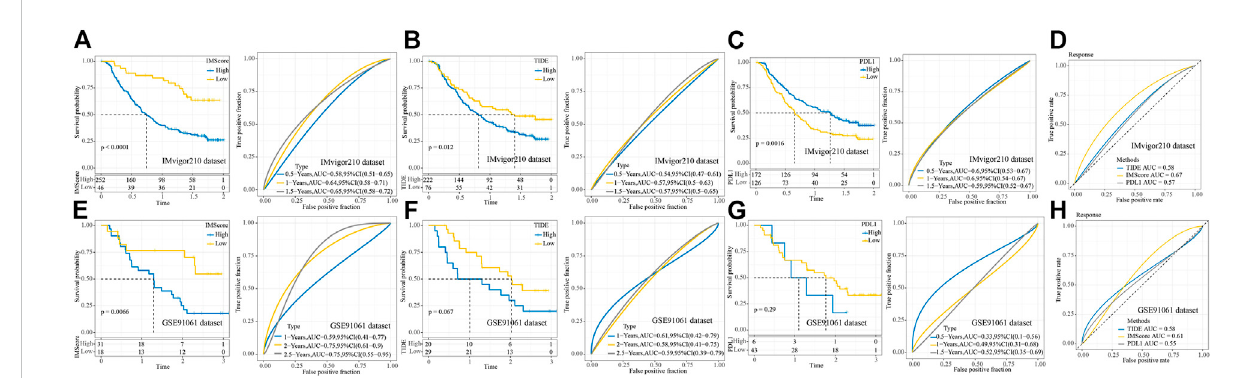
FIGURE 9 Performance of IMScore in immunotherapy datasets. (A) KM survival curve and ROC analysis of IMScore in the IMvigor210 dataset. (B) KM survival curve and ROC analysis of TIDE in the IMvigor210 dataset. (C) KM survival curve and ROC analysis of PD-L1 in the IMvigor210 dataset. (D) ROC analysis of IMScore and TIDE in the IMvigor210 dataset. (E) KM survival curve and ROC analysis of IMScore in the GSE91061 dataset. (F) KM survival curve and ROC analysis ofTIDEintheGSE91061dataset. (G) KMsurvivalcurveandROCanalysisofPD-L1 intheGSE91061 dataset. (H) ROC analysis ofIMScoreand TIDE in the GSE91061 dataset.